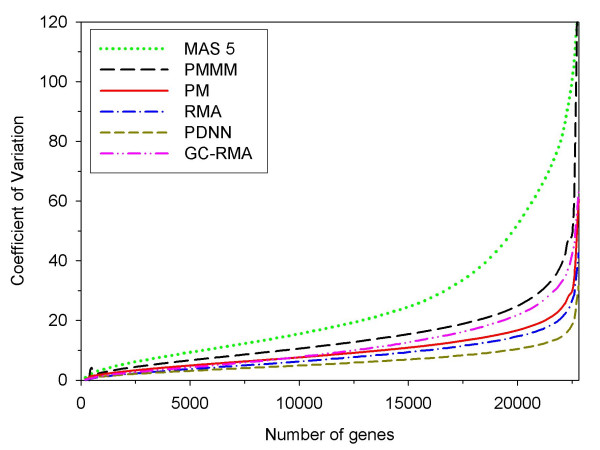
Reproducibility. Reproducibility of expression data between three biological replicates (air), compared between MAS 5.0, dChip PM, dChip PMMM, RMA, GC-RMA and PDNN. Reproducibility is calculated as the standard deviation divided by the average signal, which is the coefficient of variation (CV). The CV values are sorted from low to high. The PM, RMA and PDNN algorithms are giving the best reproducible results and MAS 5.0 the worst. Reproducibility of the two other replicated treatments ethylene and low-light gave similar results (data not shown).